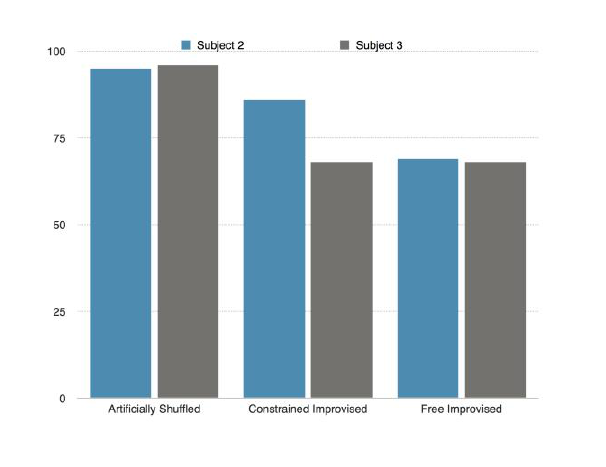
Figure 4: Classification accuracy (%) shown along the y-axis in the three distinct scenarios for Subjects 2 and